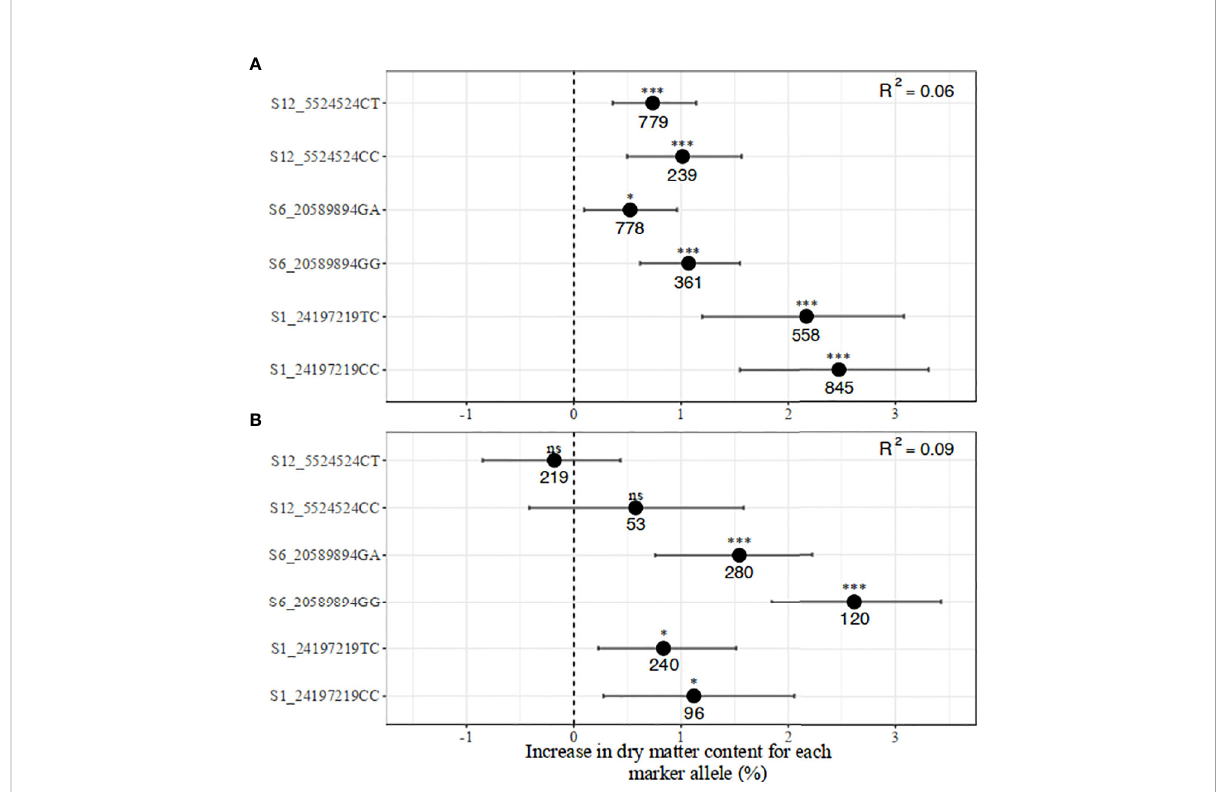
TABLE 3 Prediction performance metrics of the markers associated with increased carotenoid and dry matter contents in the training and testing sets of the breeding and pre-breeding populations. Traits Populations Chromameter b* value (Carotenoid content)